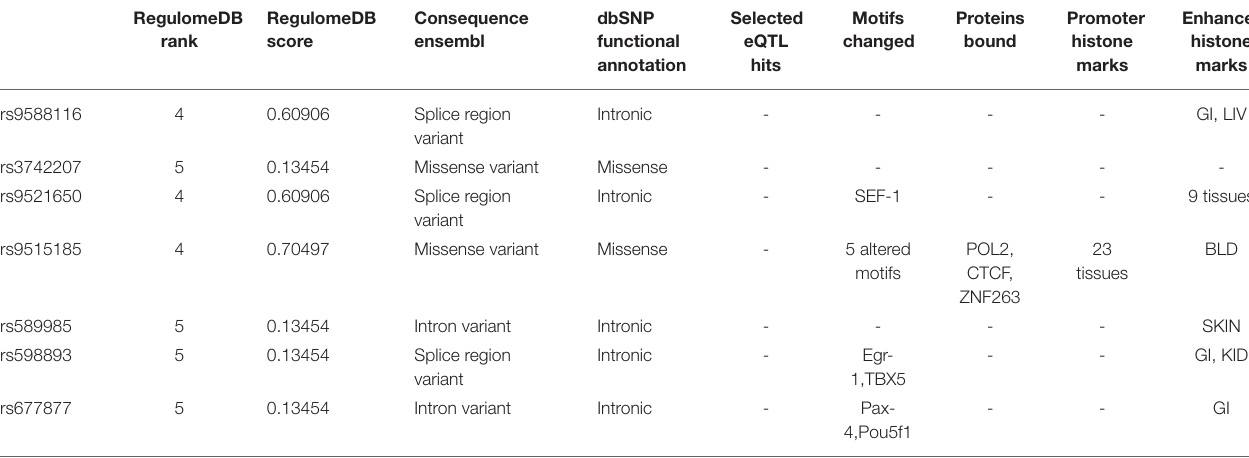
TABLE 4 | Functional annotation of common variants in COL4A1 .